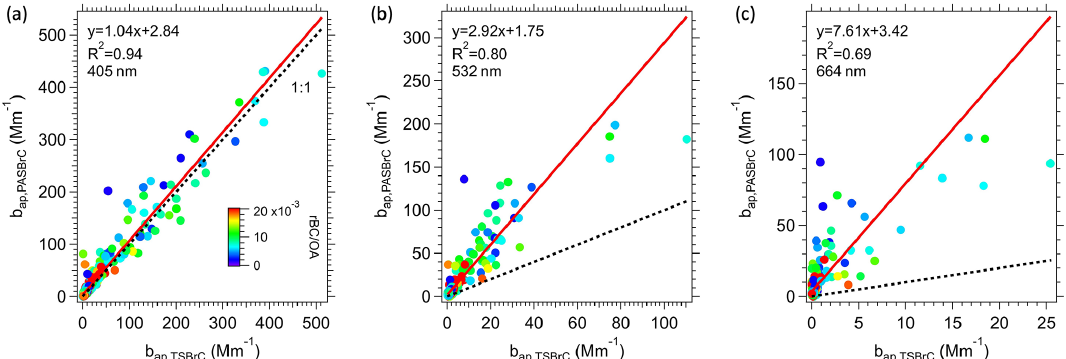
Figure 5. Various light-absorption coefficients for the average of the first transect made closest to the Williams Flats fire (23:34–23:39 7 Au- gust 2019 UTC). (a) Spectral light-absorption closure analysis, where the dashed black line is the light absorption of bare rBC and the solid line is BC considering the coating effect ( E λ ). The brown shading is soluble BrC, b ap , TSBrC ,λ , where Abs LWCC the conversion factor K λ to convert from solution to aerosol particle absorption. The upper part of the brown curve is b ap , predicted ,λ , given by Eq. (4). Uncertainties at two extreme wavelengths (300 and 700nm) for two individual components: (1) The effect or rBC coating, b ap , BC ,λ , dark grey in plot (a) , estimated to be 40%, the same as the SP2 measurement uncertainty, and (2) TS BrC b ap , TSBrC ,λ , brown, from (Abs TSBrC · K), considering the uncertainty in measurements and K . (b) Comparison between b ap , TSBrC ,λ (brown shading in plot a ) and b ap , PASBrC ,λ (difference between red and the black solid line in plot a ), color-coded by wavelength. (c) Similar to plot (b) but versus wavelength (i.e., the difference between BrC determined from the soluble measurements with the conversion factor K λ included, and BrC calculated from the PAS data).